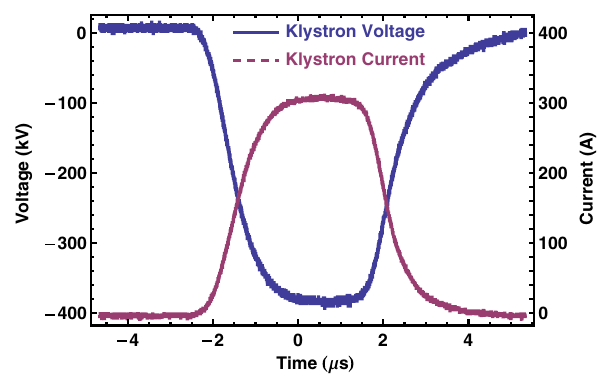
FIG. 1. Measured traces of klystron voltage (calibrated capacitative divider on the modulator output) in blue and current (klystron gun current transformer) in purple. 400 ns flat top used for rf